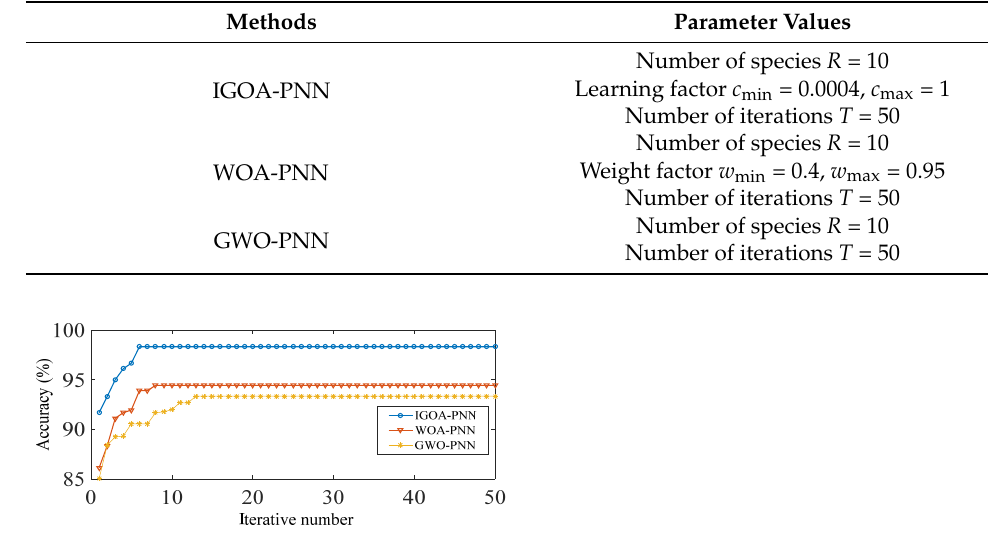
Table 2. Main parameters of different algorithms.